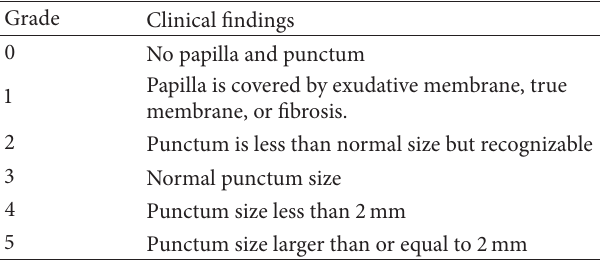
Table 1: Punctal occlusion grading ∗ .